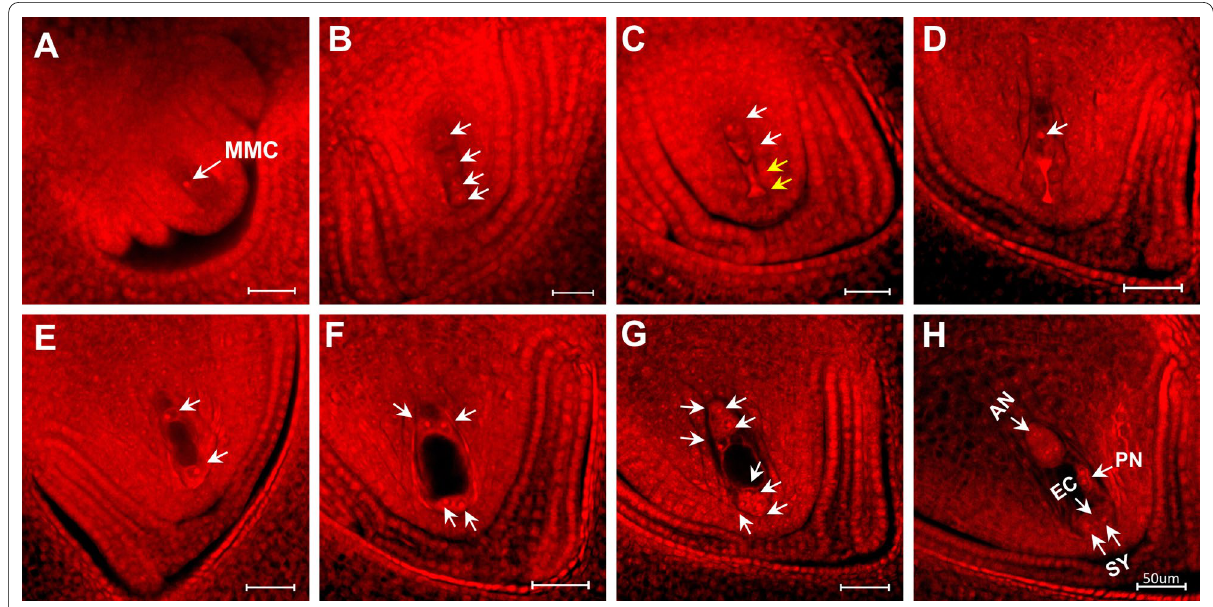
Fig. 2 Early embryo sac development in IR64 plants exposed to control temperature (30 °C) during gametogenesis stage for 6 days. AN, antipodal cells; EC, egg cell; MMC, megaspore mother cell; PN, polar nucleus; SY, synergid. ( A ) A rectangle‑like megasporocyte with inner and outer integuments; ( B ) Four megaspores linearly arranged after meiosis; ( C ) Degeneration of two megaspores (yellow arrow indicates the degenerated megaspores and white arrow shows active megaspores); ( D ) Degeneration of three megaspores (white arrow indicates the remaining functional megaspore); ( E ) A two‑nucleate embryo sac; ( F ) A four‑nucleate embryo sac; ( G ) An early stage eight‑nucleate embryo sac; and ( H ) Middle stage of eight‑nucleate embryo sac development, two polar nuclei have migrated to the central region and egg cell located near the micropylar region